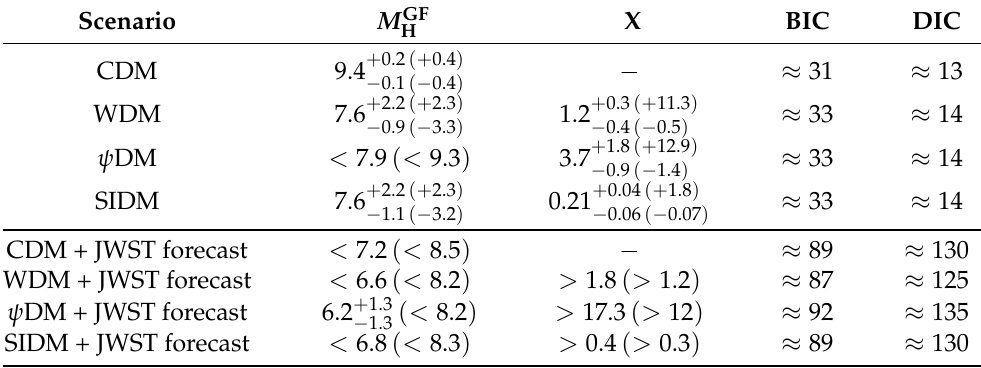
Figure 6. MCMC posterior distributions in the SIDM scenario (green contours/lines), for the thresh- old halo mass for galaxy formation M GF , and the inverse of the DM kinetic temperature at de- H coupling keV/ T X . For reference, the outcomes in the standard CDM scenario are also reported (grey contours/lines). The contours show 68% and 95% confidence intervals, and the marginalized distributions are in arbitrary units (normalized to 1 at their maximum value). Table 3. Marginalized posterior estimates (mean, 68% and 95% confidence limits are reported) of the parameters of the MCMC analysis for the different DM scenarios considered in the main text (WDM, ψ DM and SIDM). Specifically, M GF is the threshold halo mass for galaxy formation, while the H astroparticle quantity X in the third column represents the particle mass m X in keV for WDM, the particle mass m X in 10 − 22 eV for ψ DM, and kinetic temperature T X in keV for SIDM; The last two columns refer to the value of the Bayes information criterion (BIC) and the Deviance information criterium (DIC) for model comparison; see Section 3. The top half of the Table refers to the current constraints on the cosmic SFR density, while the bottom half to the forecasts for JWST observations extended down to UV magnitude M UV ≈ − 13, see Section 3.1 for